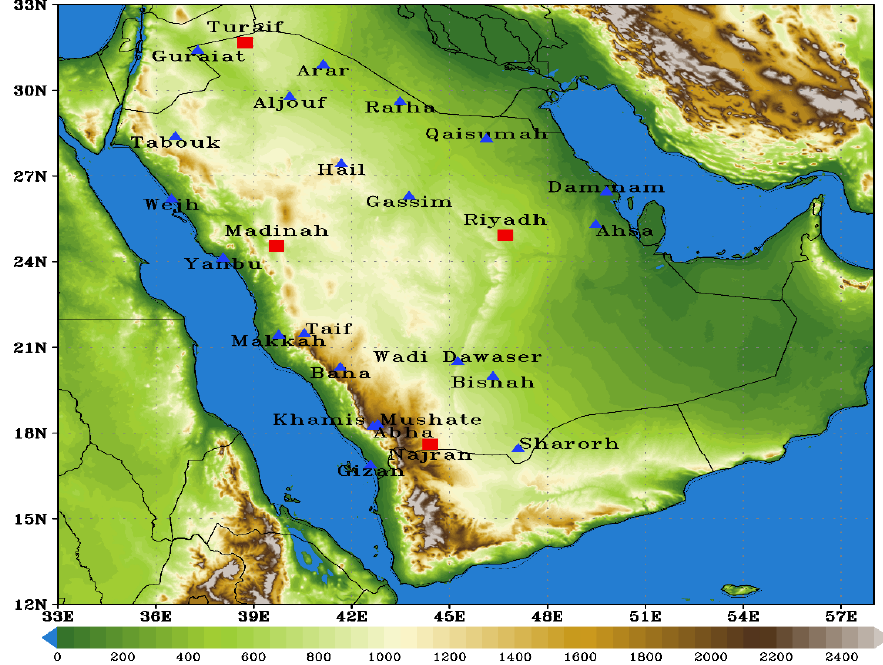
Figure 1. The name and location of Saudi Arabia stations are marked by blue triangles with shaded elevations (m). The red mark represents the stations that were used to evaluate the ERA ‐ 5 data. Table 1. Name, location, elevation, and the available data period for each of Saudi Arabia stations.